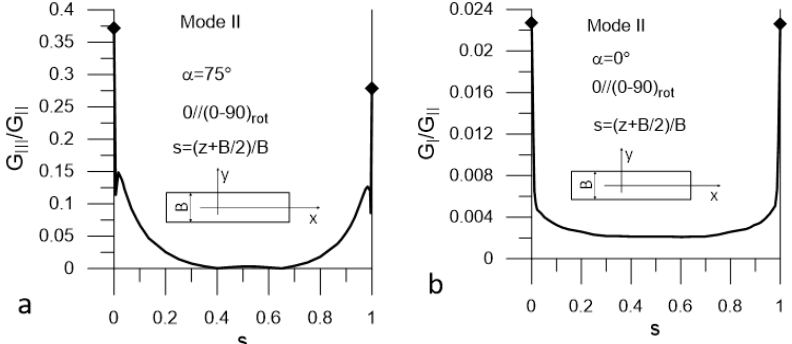
Figure 10. Mode II loading; ( a ) G III /G II (s) ratio and ( b ) G I /G II (s) ratio for Laminate A.